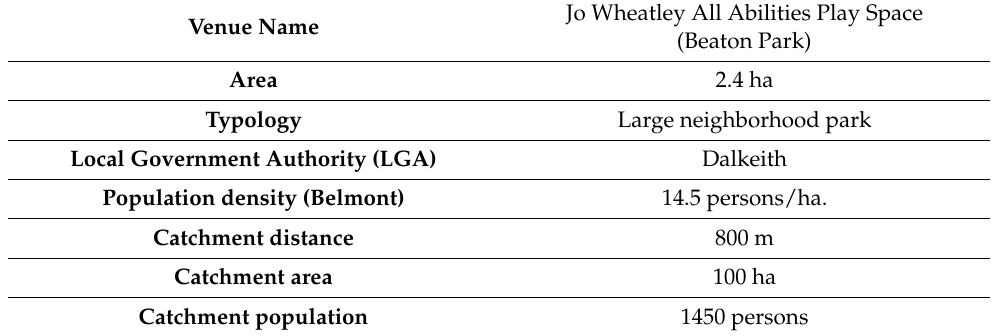
Table 1. Urban Metrics